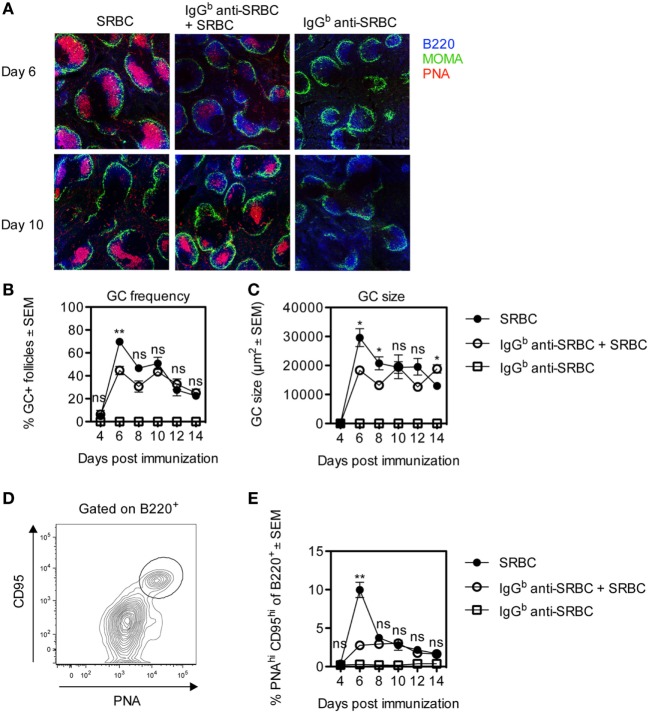
Development of germinal centers (GCs) in mice immunized with allogeneic IgG anti-sheep red blood cells (SRBC) together with SRBC. BALB/c mice were immunized with 10 µg IgGb anti-SRBC 30 min prior to administration of 5 × 106 SRBC (open circles). Controls were given 5 × 106 SRBC alone (filled circles) or 10 µg IgGb anti-SRBC alone (open squares). On days 4, 6, 8, 10, 12, and 14 after immunization, spleens were harvested. Half of each spleen was processed for analysis of GC B-cells by flow cytometry, and the other half for confocal laser scanning microscopy. (A) Visualization of PNA+ GCs in spleen sections 6 and 10 days after immunization: B220+ B-cells (blue), MOMA+ metallophilic macrophages (green), and PNA+ GCs (red). Image sizes are 1,500 µm × 1,500 µm. (B) Average percentage of follicles containing PNA+ GCs of total number of follicles. (C) Average size of PNA+ areas in the GCs in two non-consecutive spleen sections per mouse (10–40 GCs/section were measured) quantified as the area in square micrometers for each group. (D) GC B-cells gated as PNAhiCD95hi of B220+ lymphocytes. (E) Percentage of PNAhiCD95hi GC B-cells among B220+ lymphocytes. Data are representative of two independent experiments (n = 3/group) (ns, p > 0.05; *p < 0.05; **p < 0.01; ***p < 0.001).